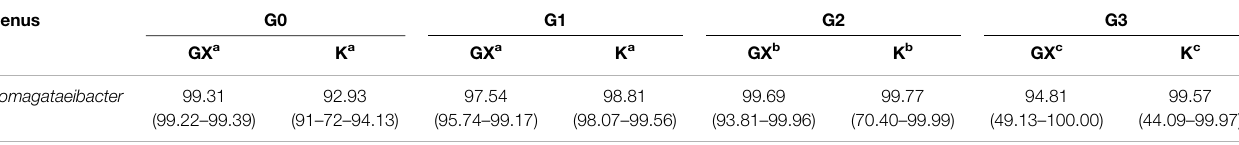
TABLE 2 | Median ASV relative abundancies of Komagataeibacter in pellicles across generations. Genus